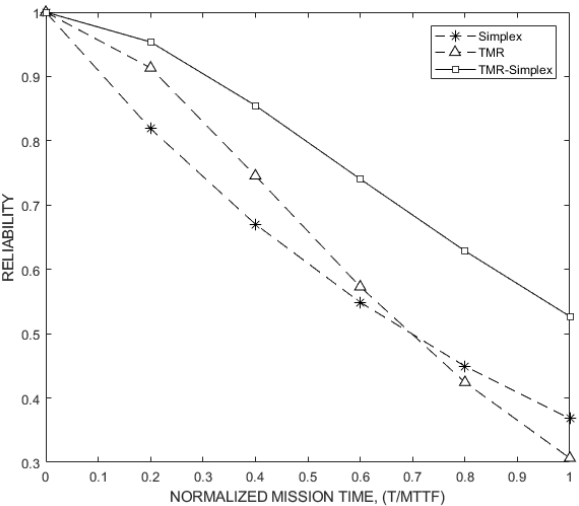
Figure 1. Reliability versus normalized mission time for Simplex, TMR, and TMR/Simplex sys- tems.